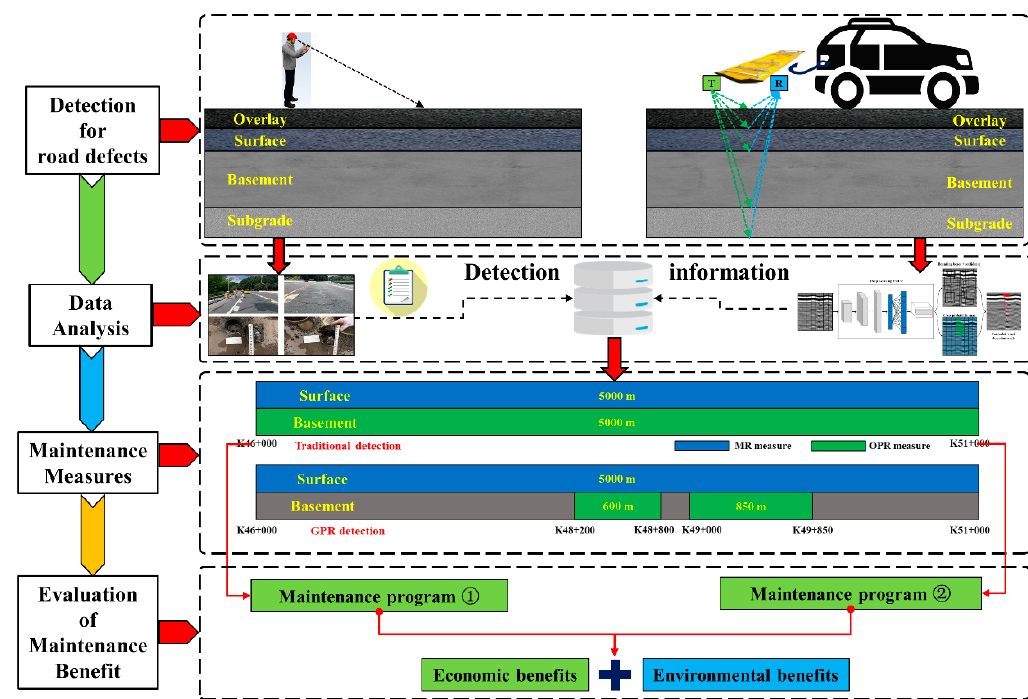
Figure 1. Technical roadmap of the detection, data analysis, maintenance measures, and benefits analysis based on traditional detection and ground-penetrating radar (GPR) detection in this research.